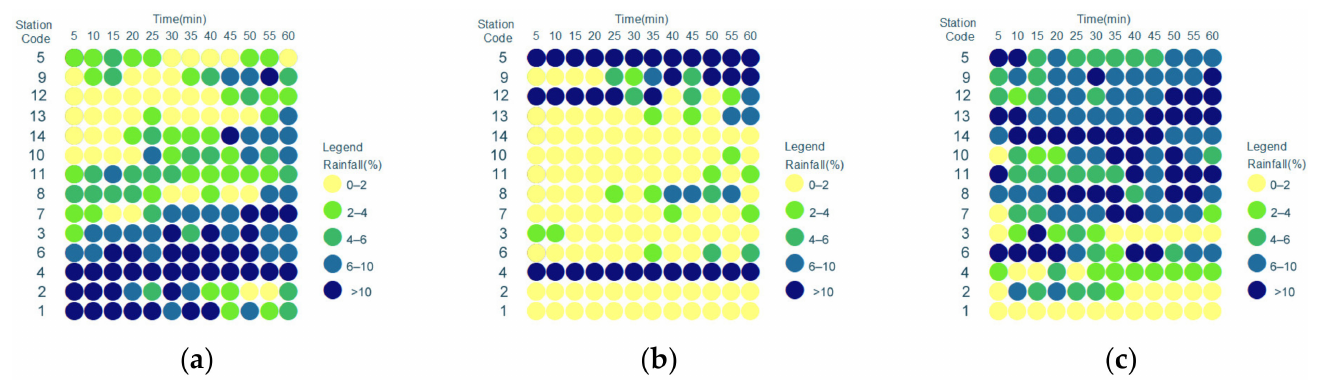
Figure 6. Matrixes of 3 modes. ( a ) Mode 1; ( b ) mode 2; ( c ) mode